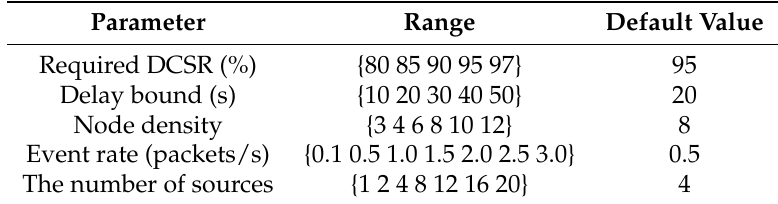
Table 2. Network parameters. DCSR, delay-constrained success